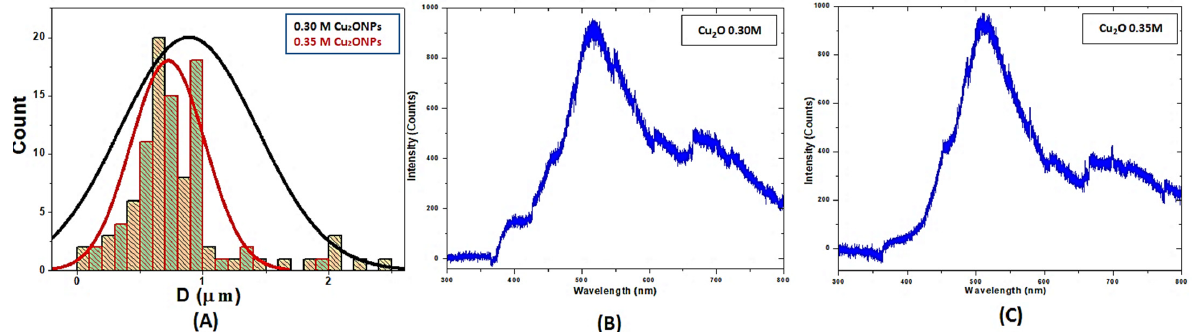
Figure 2. Average grain size distribution of 0.30 and 0.35 of Cu 2 O NPs ( A ) and room temperature PL spectra of fabricated Cu 2 ONPs ( B , C ).